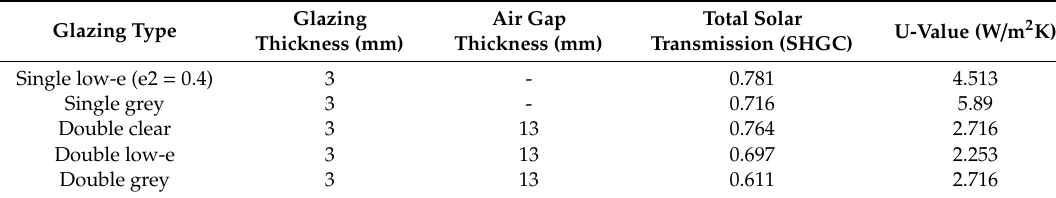
Table 5. Glazing types and their properties.